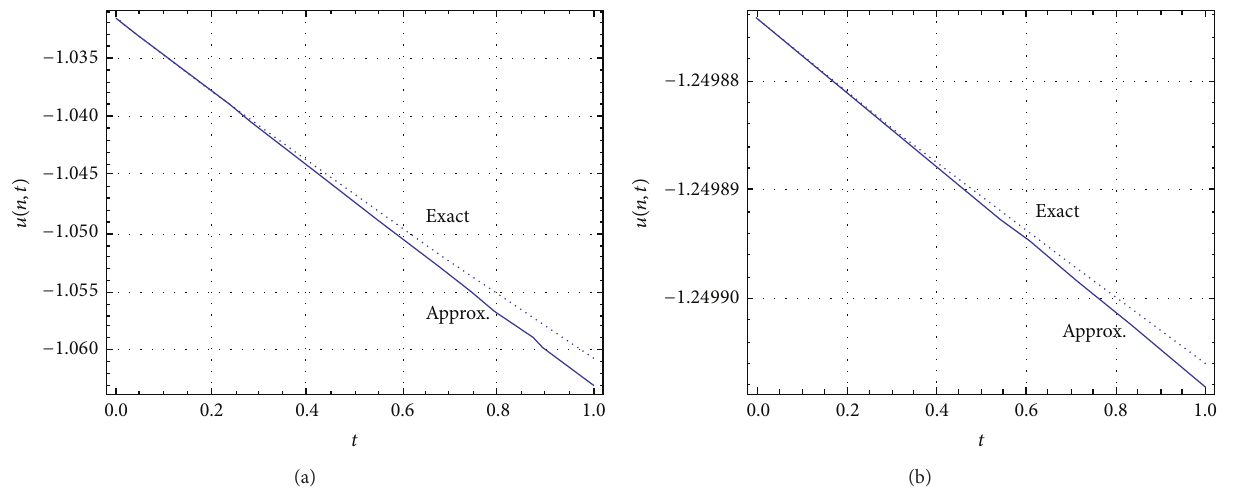
Figure 3: The behavior of the approximate solution using HPTM via optimal parameter when 𝜇 = 0.5 and 1.